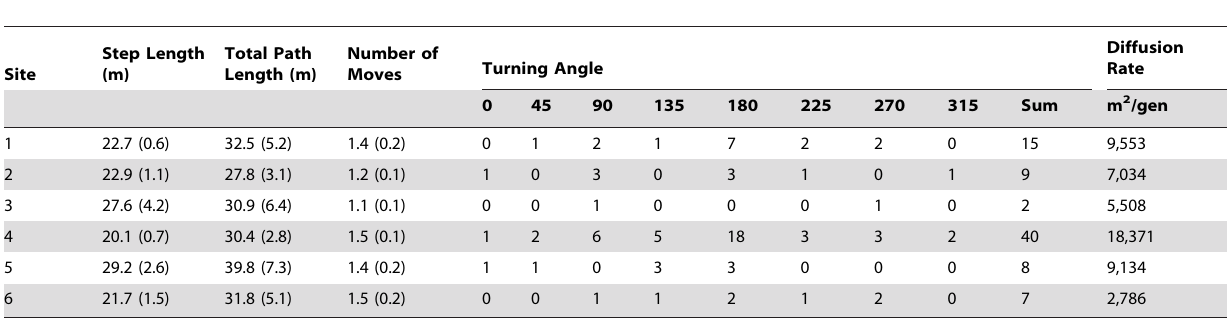
Table 2. Mean step length, total path length, number of moves, turning angles, and population-level diffusion rates for S. arenicolus across 6 sites.